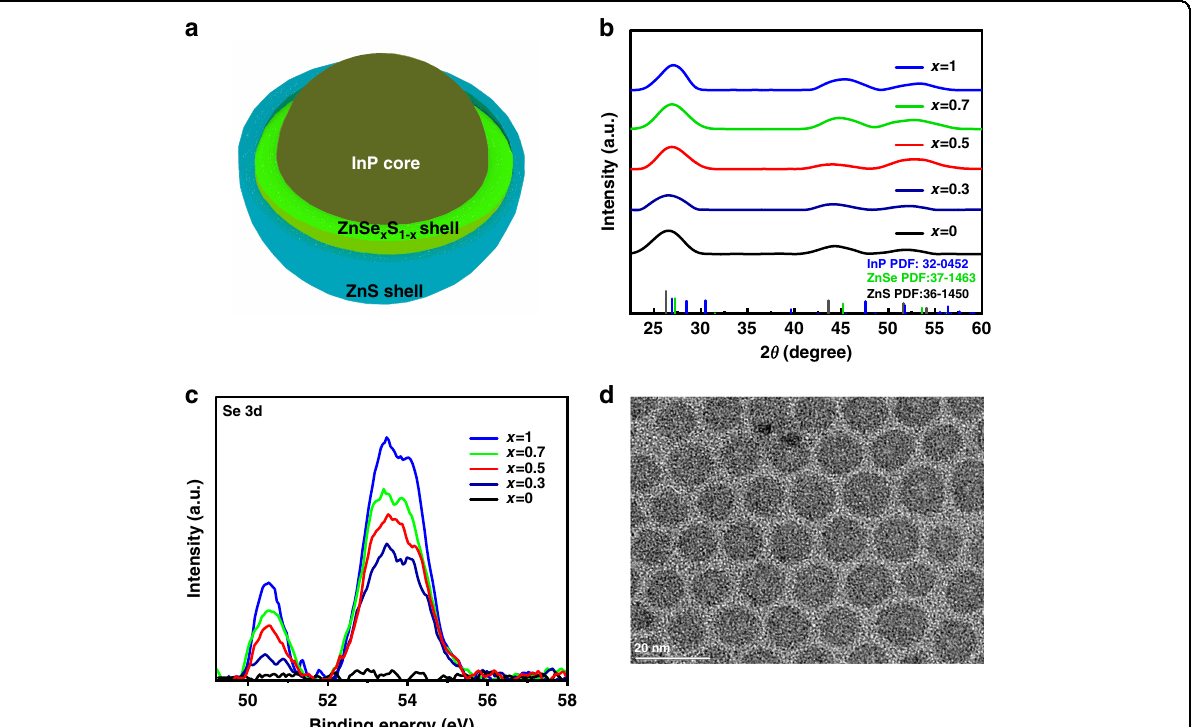
Fig. 1 Structural and morphological properties of InP-based QDs. a Schematic diagram of InP/ZnSe x S 1 − x /ZnS structure. b XRD patterns for InP/ ZnSe x S 1 − x QDs. c XPS spectra of Se 3d regions of InP/ZnSe x S 1 − x QDs. d TEM images of InP/ZnSe 0.7 S 0.3 /ZnS